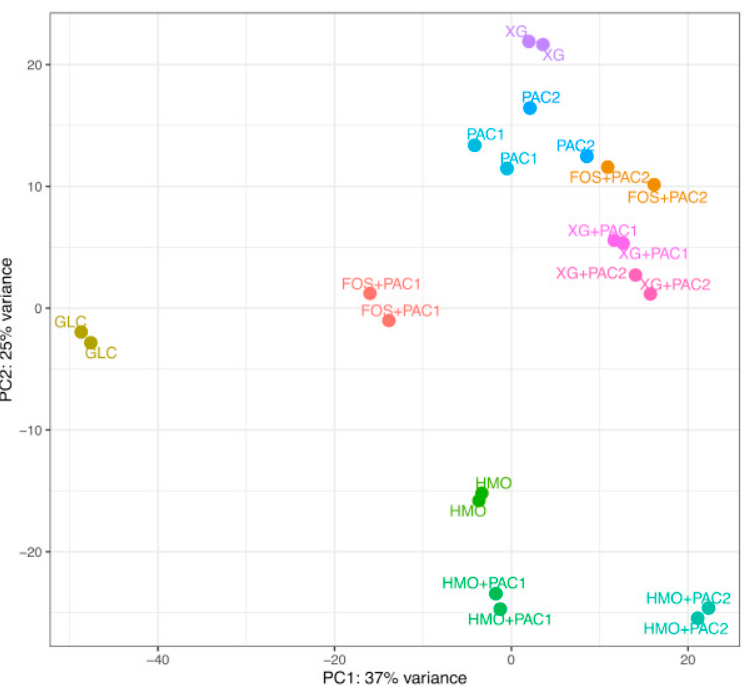
Figure 5. Principal component analysis of the Lactobacillus plantarum transcriptome response to cranberry substrates. Circles indicate distances between L. plantarum whole transcriptomes in response to glucose (GLC), cranberry proanthocyanidins (PACs) alone, fructooligosaccharides (FOS) with PACs, human milk oligosaccharides (HMO) with PACs, and xyloglucans (XG) with PACs.